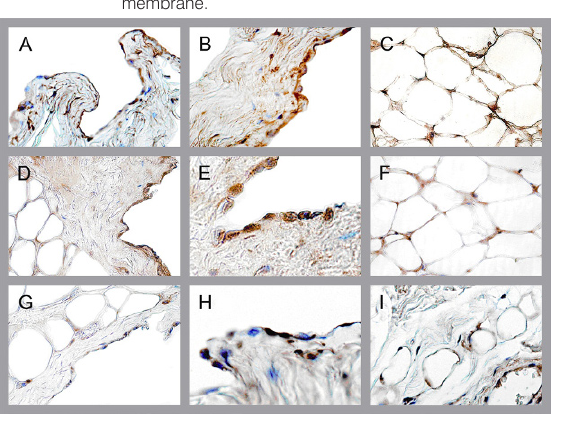
Panels A, B and C: Immunohistochemical detection of PAI-1 in mesothelium and submesothelial layer (A - original enlargment 100x, B - 400x) and in adipocytes (original enlargment 100x). Panels D, E and F: Immunohistochemical detection of tPA in mesothelium and submesothelial layer (A - original enlargment 100x, B - 400x) and in adipocytes (original enlargment 100x). Panels G, H and I: Immunohistochemical detection of uPA in mesothelium and submesothelial layer (A - original enlargment 100x, B - 400x) and in adipocytes and vessel walls (Panel I-original magnification Figure 2. Area fractions of PAI-1, uPA and tPA within the adipose tissue